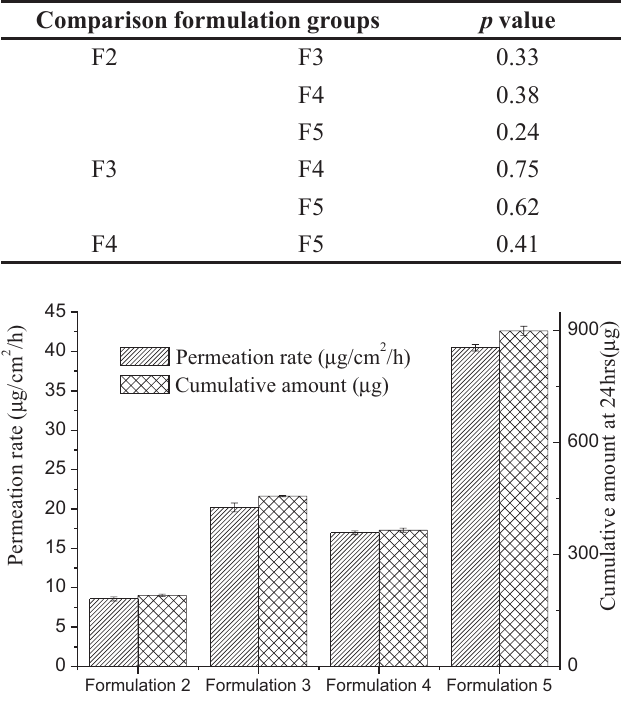
FIGURE 6 - In vitro release of ISDN in four formulations with different penetration enhancers across through the rats’ ex-vivo skin.